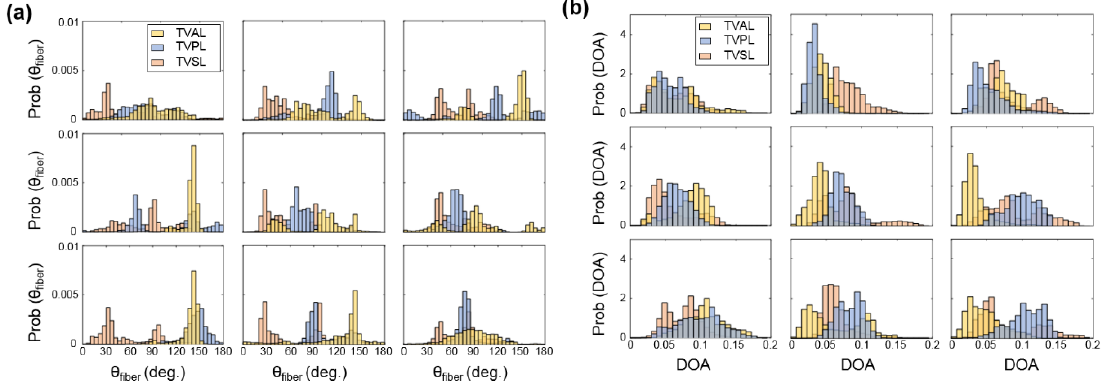
Figure 5. 3 × 3 grid comparisons of ( a ) the predicted θ fiber , and ( b ) the predicted DOA in the unloaded state for the TVAL, TVPL, and TVSL specimens from heart #1. Table 5. Mean, skewness, and standard deviation (SD) for the predicted θ 𝑓𝑖𝑏𝑒𝑟 and the DOA of the entire tissue’s ROI (see right column in Figure 3a–c) for the TVAL, TVPL, and TVSL specimens from heart #1, considering various biaxial tension loading conditions.